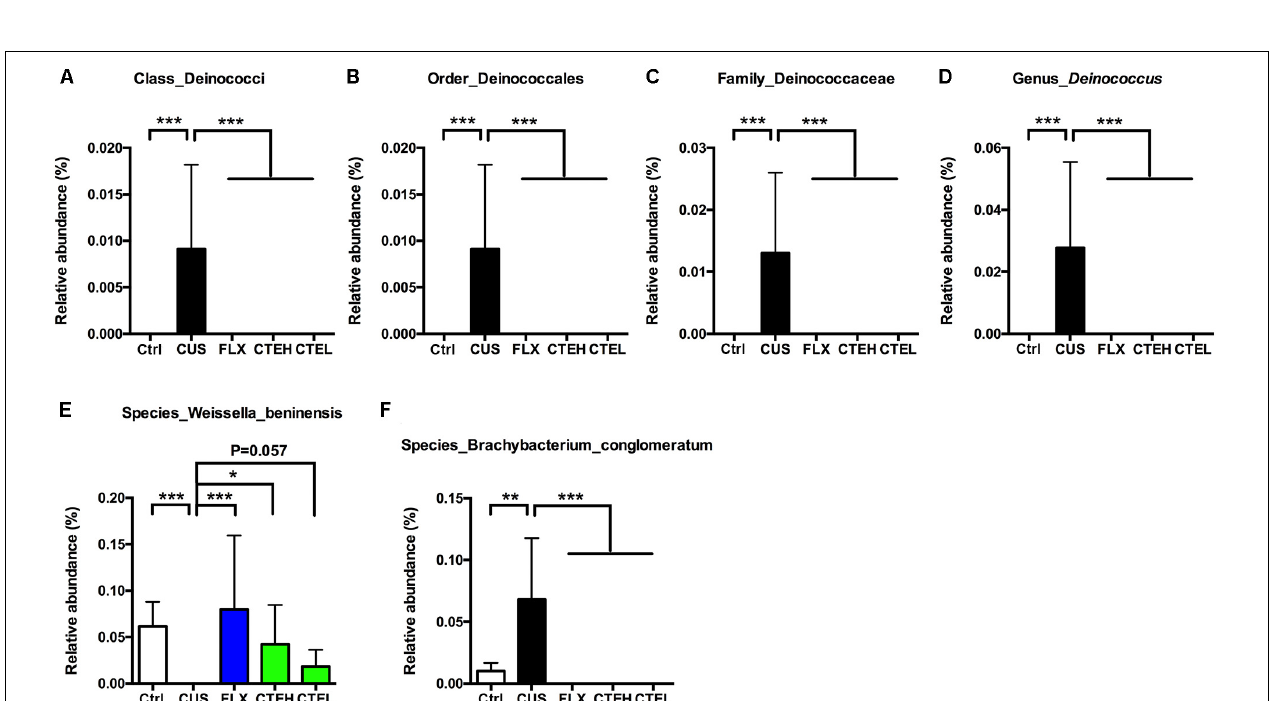
FIGURE 4 | Relative abundance of selected genera with significant differences among each group. Relative abundance of Bacteroides (A) , Ruminococcus (B) , Parabacteroides (C) , Butyricimonas (D) , Deinococcus (E) , Weissella (F) , Trichococcus (G) , and Brachybacterium (H) . Ctrl, control; CUS, chronic unpredictable stress; FLX, fluoxetine; CTEH, C. tubulosa extract high dose; CTEL, C. tubulosa extract low dose. ∗ P < 0.05, ∗∗ P < 0.01, ∗∗∗ P < 0.001 ( n = 8, mean ± SEM).